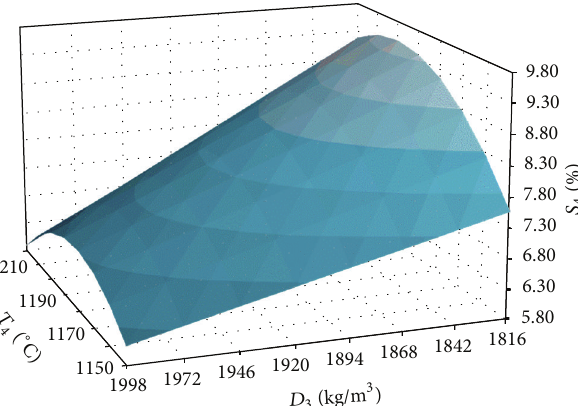
Figure10:Three-dimensionalresponsesurface:linearfiringshrink- age ( 𝑆 4 ) as a function of the maximum firing temperature ( 𝑇 4 ) and dry bulk density ( 𝐷 3